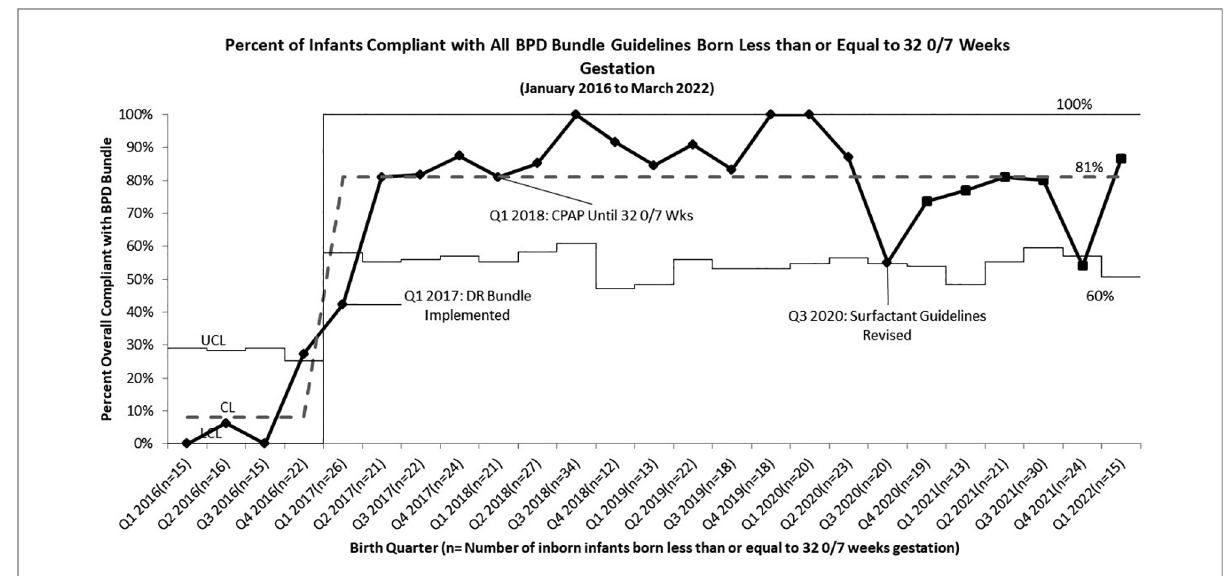
FIGURE 4 p chart of compliance with all BPD bundle guidelines for infants born less than or equal to 32 0/7 weeks